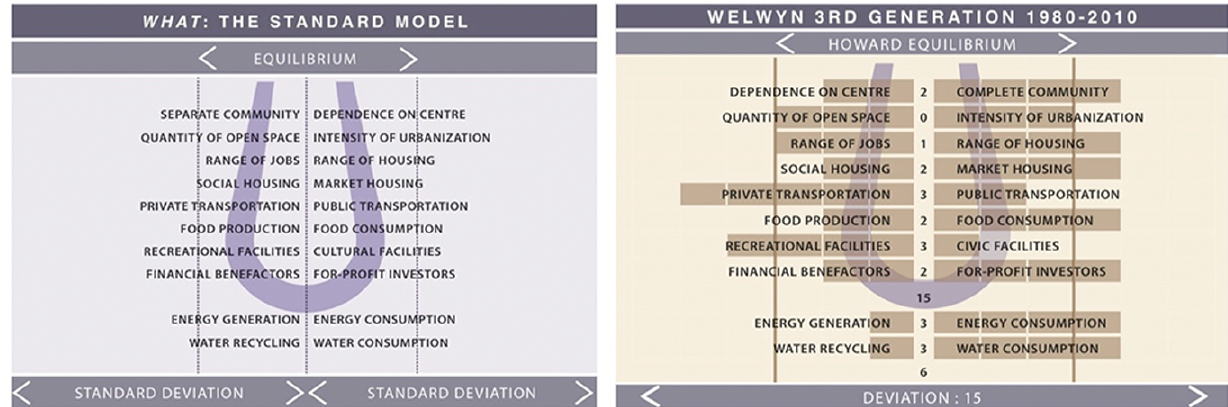
Figure 5. The DPZ assessment model inspired by garden cities: the standard model and its application on the 3 rd generation of Welwyn Garden City. Source: Duany et al. (2014, pp. 15,